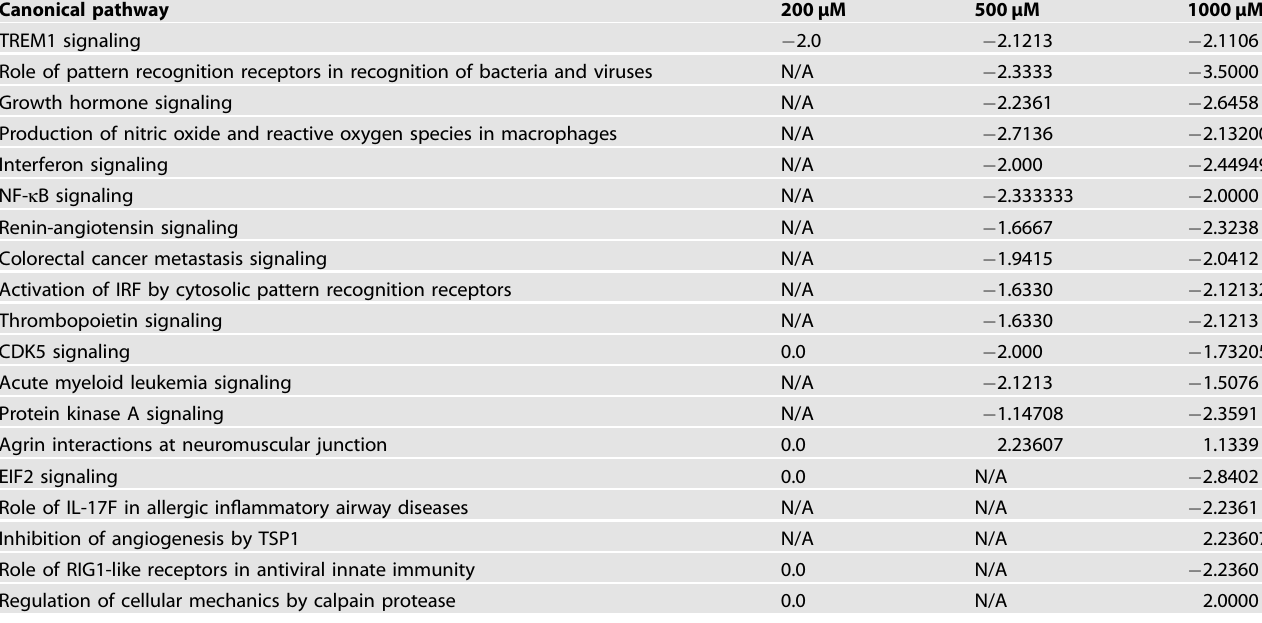
Fig. 2 Heat map representing the relevant canonical pathways of ASA treatments at 200, 500, and 1000 μ M. Most activated or inhibited canonical pathways as estimated by the z -score (± ≥ 2) for each comparison from ingenuity Pathway analysis (IPA). Blue denotes predicted activation and orange predicted inhibition. Table 2. Relevant upstream transcription regulators at 200, 500, and 1000 μ M of ASA